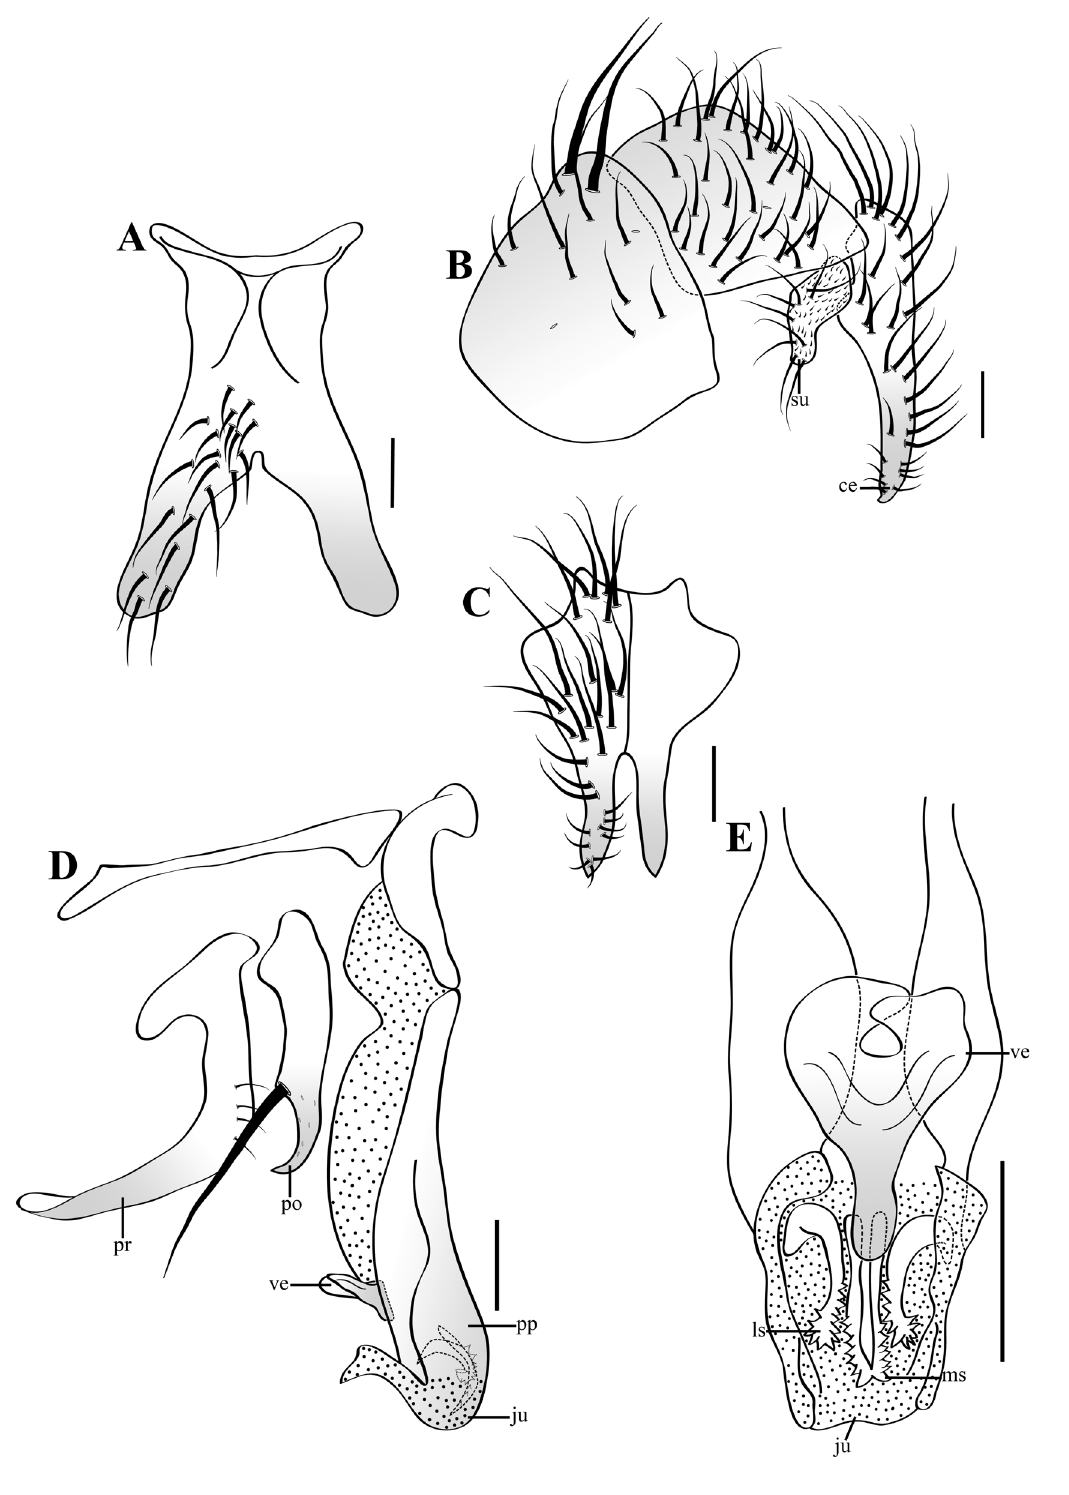
Fig. 12. Dexosarcophaga pallida sp. nov., ♂, holotype (NHRS [lost]). A . Sternite 5, ventral view. B . Syntergosternite 7 + 8, epandrium, cercus and surstylus, lateral view. C . Cerci, posterior view. D . Phallus and associated structures, lateral view. E . Distiphallus, ventral view. Abbreviations: see Material and methods. Scale bars = 0.1